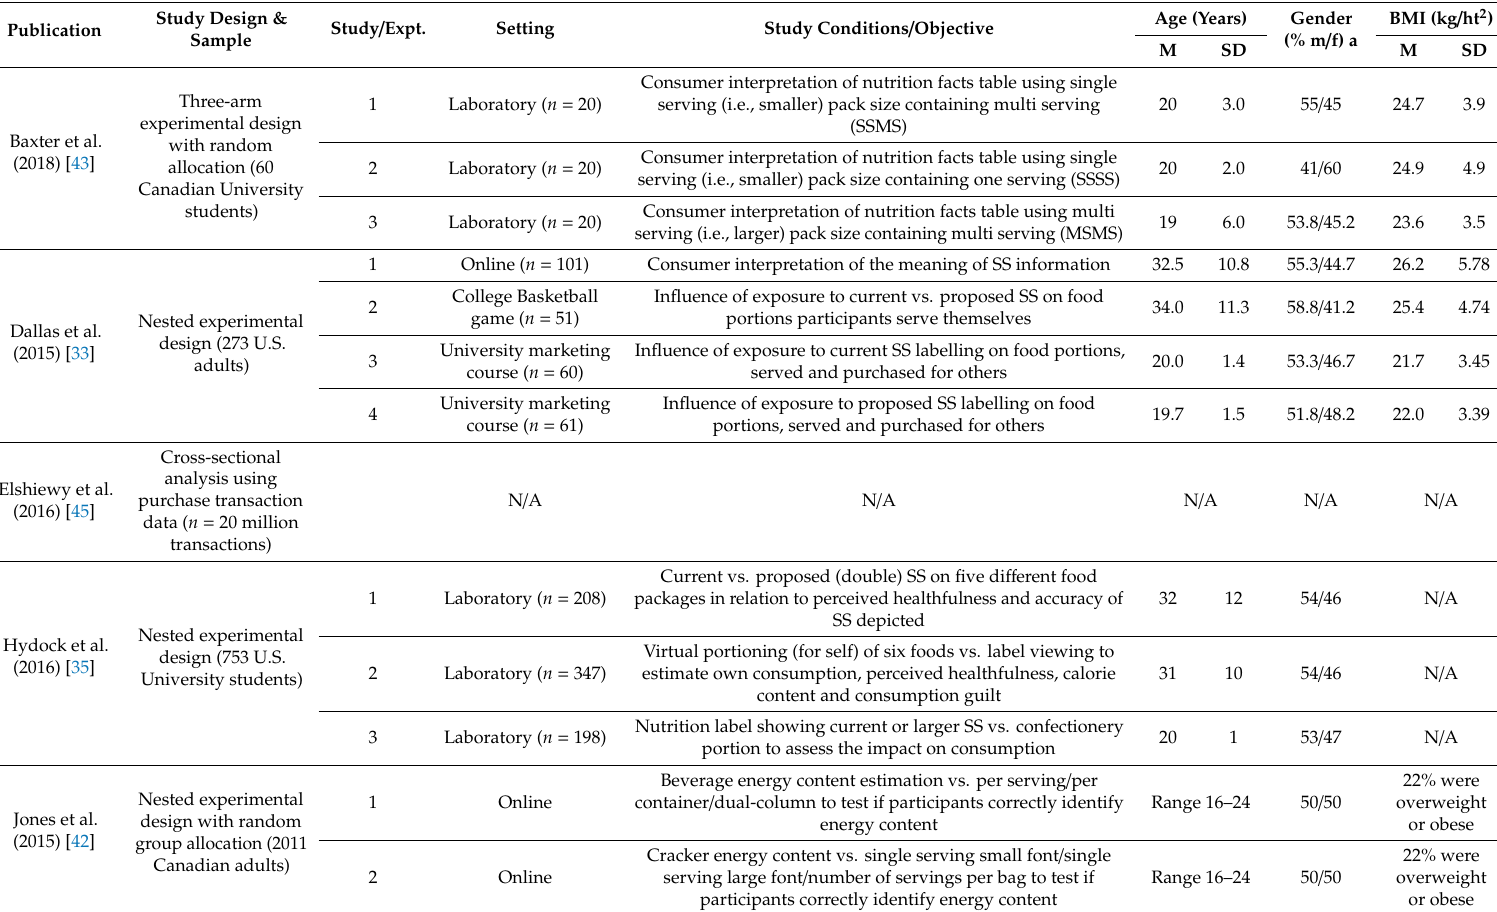
Table 1. Food label serving size information scoping review: summary of included